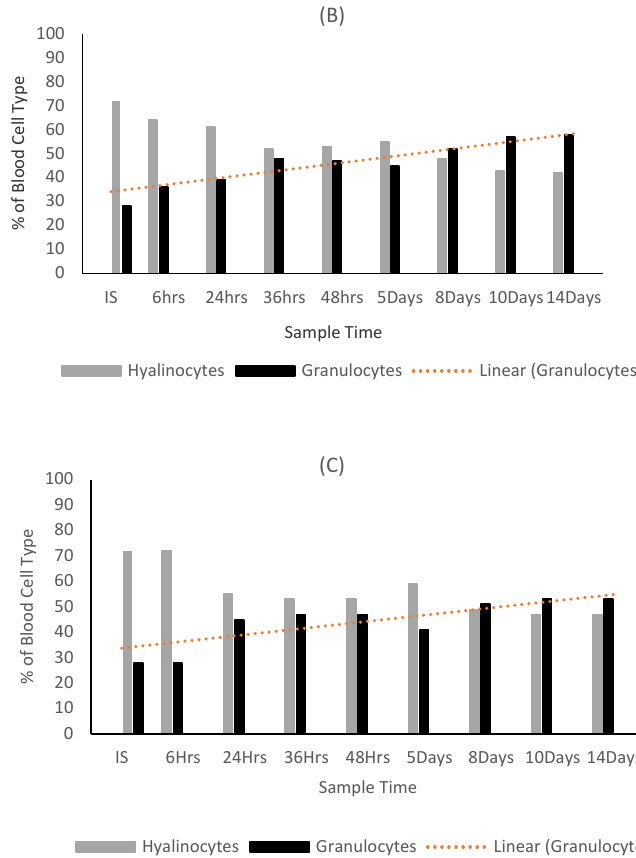
Figure 9. Ratio of hyalinocytes to granulocytes in the ( A ) control, ( B ) carrageenan treated and ( C ) fucoidan treated oysters .